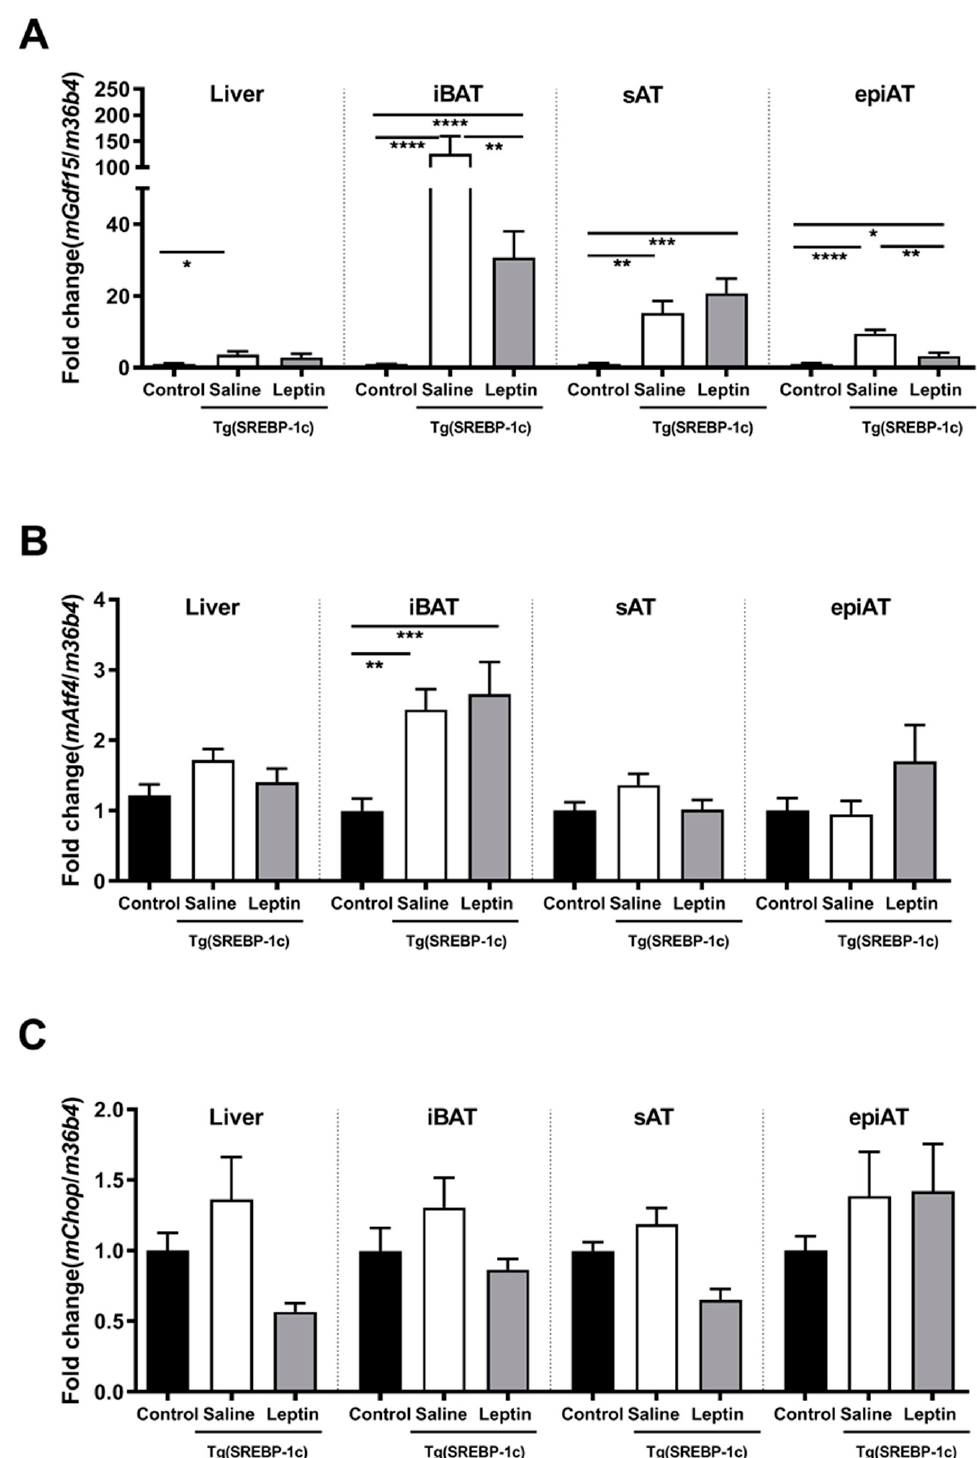
Figure 1. Effect of leptin treatment (3.0 mg/kg BW/d) on Gdf15 ( A ), Aft4 ( B ), and Chop ( C ), mRNA expression relative to 36B4 ( n ≥ 8 per group) in liver, intrascapular brown (iBAT), subcutaneous (sAT), and epididymal (epiAT) adipose tissue of Tg(aP2-SREBF1c). Data are presented as means ± SEM. Differences were assessed by one-way ANOVA corrected by Bonferroni–Holm. * indicates p < 0.05, ** p < 0.01, *** p < 0.001, **** p < 0.0001.